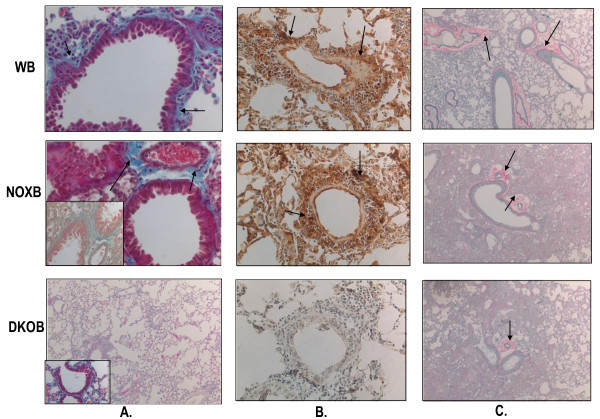
Increased inflammation and fibrosis in lung of WT and gp91phox-/- mice but not MMP12gp91phox double knockout mice. At 21d post-bleomycin treatment, mice were sacrificed and lungs were fixed overnight in 4% paraformaldehyde and embedded in paraffin. Sections of 8 m were dye-stained by A, Masson's Trichrome stain and C, Picro Sirius red and were immunostained with TGFb antibody and color developed by Diaminobenzidine (DAB). (B). Arrows indicate blue collagen deposits (A), TGFb positive stain (B) and red collagen staining (C). In A, pink-purple stains indicate cytoplasm, and blue the nuclei of inflammatory cells. Light blue stains are collagenous deposits. While wildtype and gp91phox-/- (designated as NOX-/-) show increased collagen deposits and inflammation around airways post-ovalbumin (all sections are those of post- ovalbumin lung), the MMP-12-gp91phox double knockout lung shows minimum collagen deposition as well as TGFb expression. While A and B were at 60 × magnification, C was at 10 × magnification. A inset shows another area of collagen deposition in bleomycin-treated wildtype; NOXB and DKOB were bleomycin-treated gp01 phox-/- and double knockout mice respectively. The photomicrographs were taken using an Olympus VX4L microscope and Nikon digital camera. All photomicrographs were at 60 × magnification. Abbreviations: WB, wildtype mice treated with bleomycin; NOXB, bleomycin-treated gp91phox null; DKOB, bleomycin-treated MMP12- gp91phox double knockout.